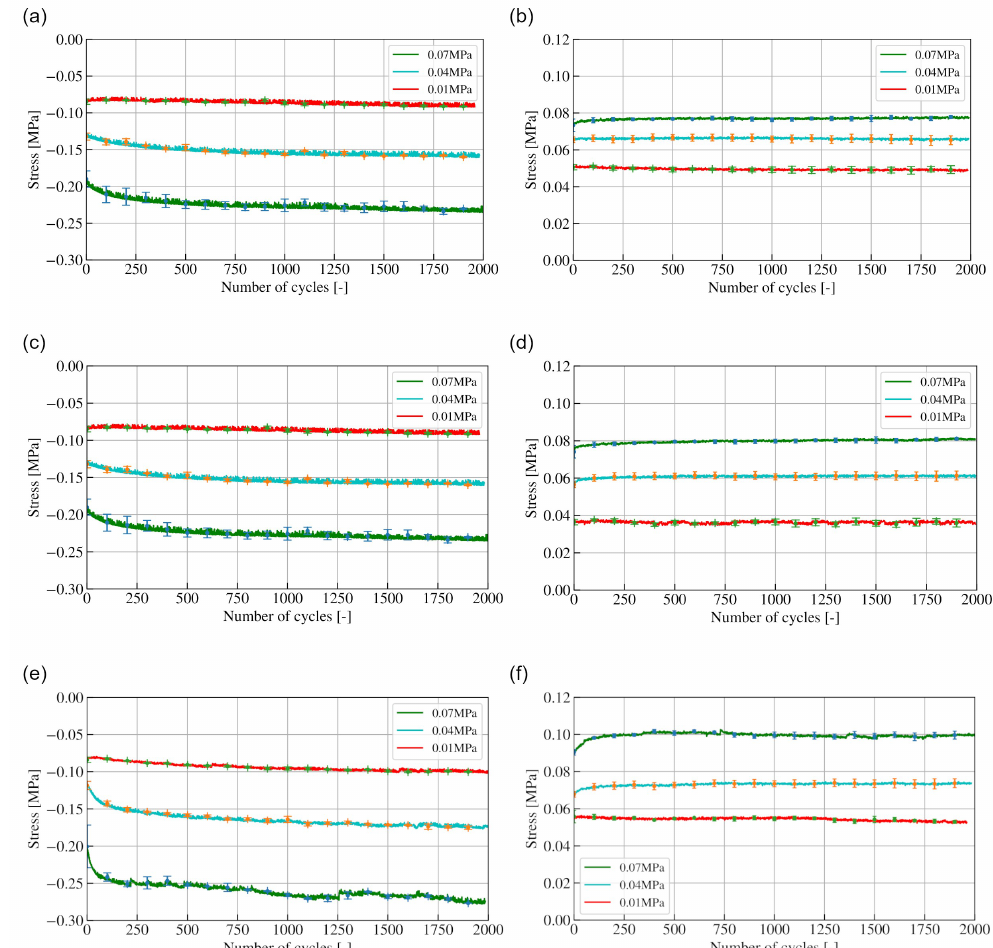
Figure 4. Maximum stress values as a function of number of cycles for POM compression ( a ) and tension ( b ), PC+ABS compression ( c ) and tension ( d ) and PP compression ( e ) and tension ( f